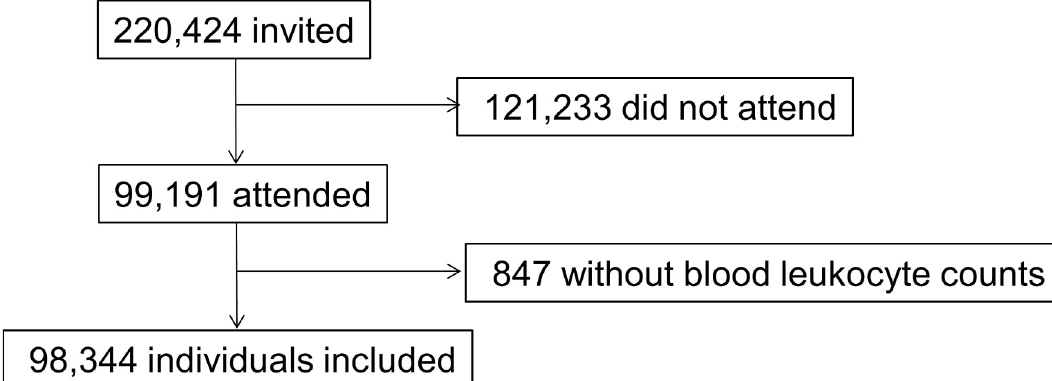
Fig 1. Flow chart of individuals from the Copenhagen General Population